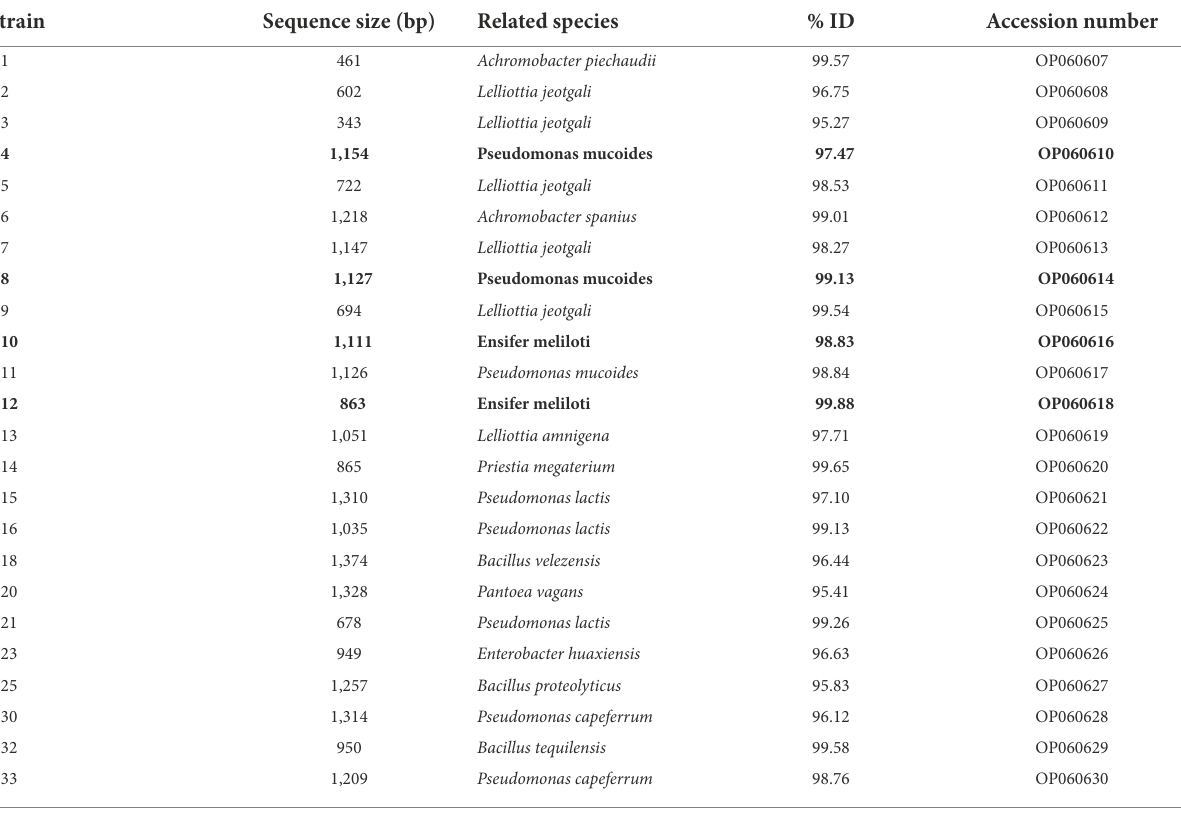
TABLE 2 Identification of cultivable entophytic bacteria isolated from nodules of Medicago spp. using the EzBiocloud database.